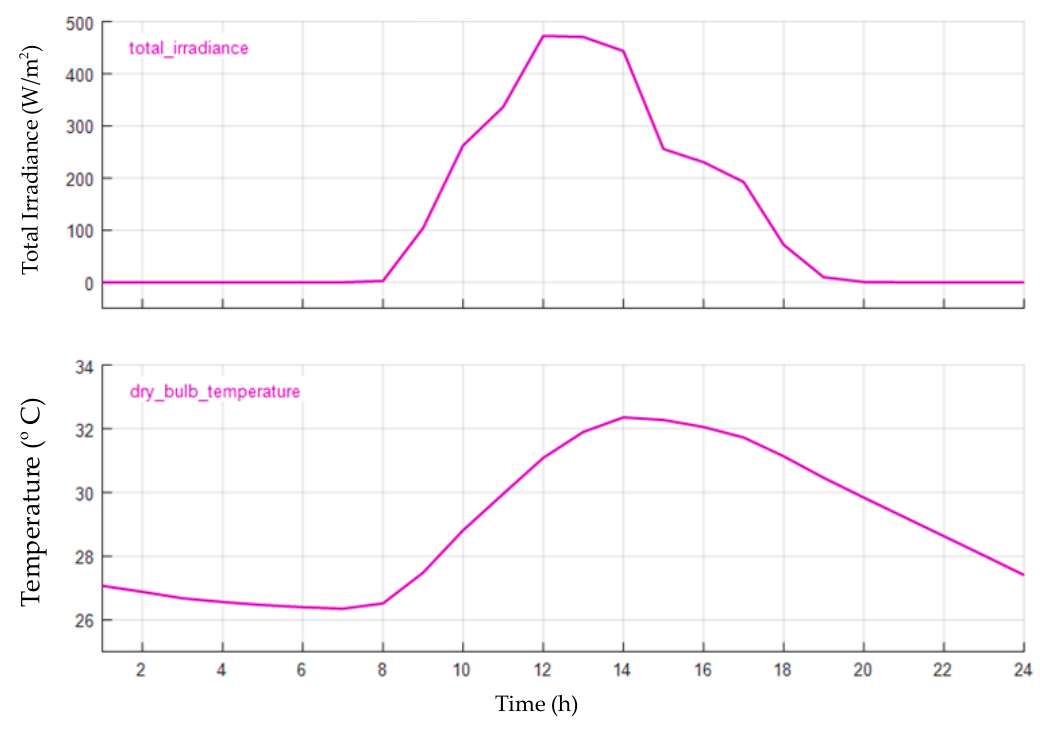
Figure 13. Input data to the solar panel.